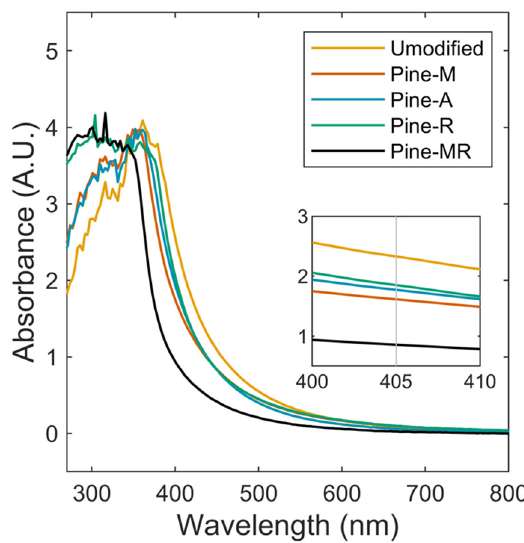
Figure 2. UV–Vis absorption curves for modified Pine lignin showing UV absorption decrease. The inset shows difference in absorption at the 390–420 nm range.